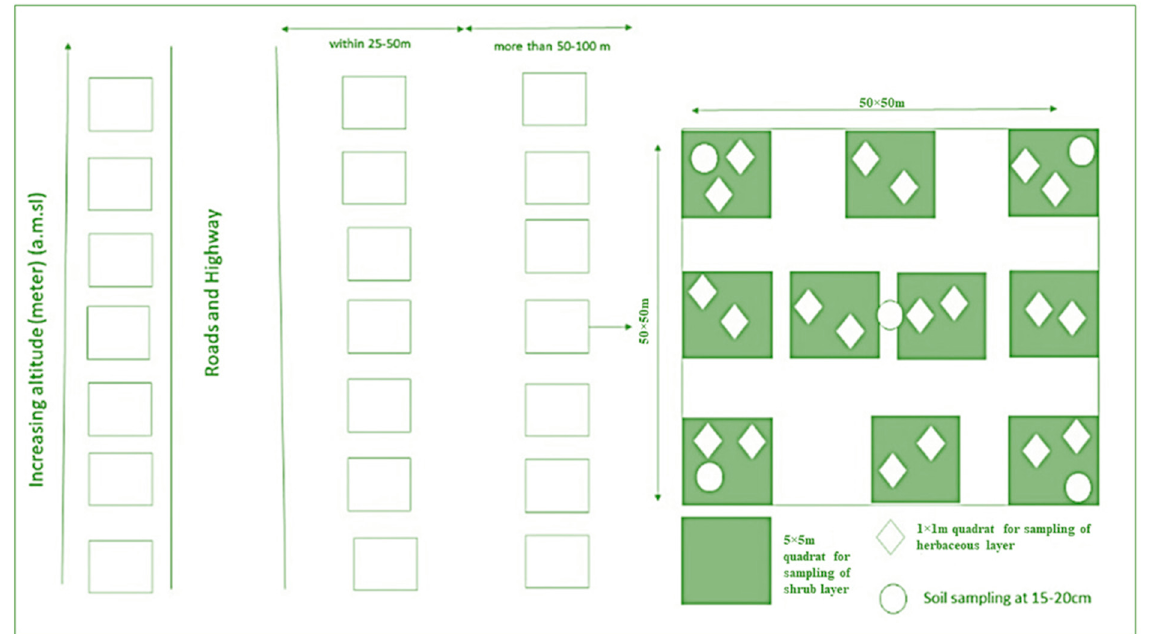
Figure 1. Schematic representation of sampling design for disturbed (within 50 m) and undis- turbed sites (more than 50 m).